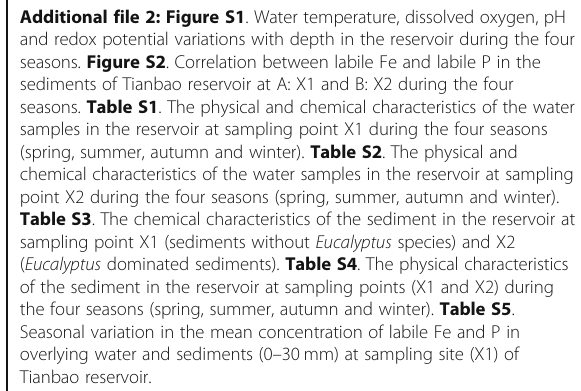
Figure S2 . Correlation between labile Fe and labile P in the sediments of Tianbao reservoir at A: X1 and B: X2 during the four seasons. Table S1 . The physical and chemical characteristics of the water samples in the reservoir at sampling point X1 during the four seasons (spring, summer, autumn and winter). Table S2 . The physical and chemical characteristics of the water samples in the reservoir at sampling point X2 during the four seasons (spring, summer, autumn and winter). Table S3 . The chemical characteristics of the sediment in the reservoir at sampling point X1 (sediments without Eucalyptus species) and X2 ( Eucalyptus dominated sediments). Table S4 . The physical characteristics of the sediment in the reservoir at sampling points (X1 and X2) during the four seasons (spring, summer, autumn and winter). Table S5 . Seasonal variation in the mean concentration of labile Fe and P in overlying water and sediments (0 – 30mm) at sampling site (X1) of Tianbao reservoir.